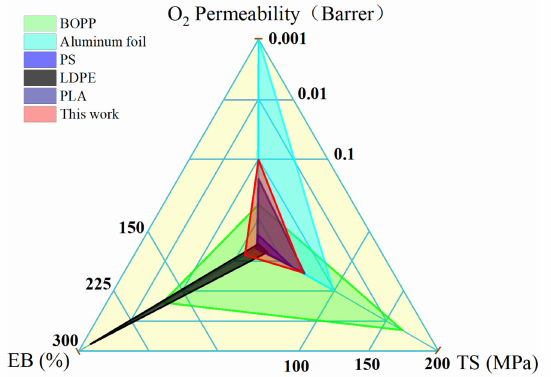
Figure 6. Performance triangle diagram to compare the O 2 permeability, TS, and EB of PLA/PVA1/OMMT film with other packaging films. The overall performance of each material is represented by the area of corresponding triangle. The properties of commercial packaging films are taken from the literature: BOPP [34], aluminum foil [35], PS [36,37], LDPE [38,39], and neat PLA